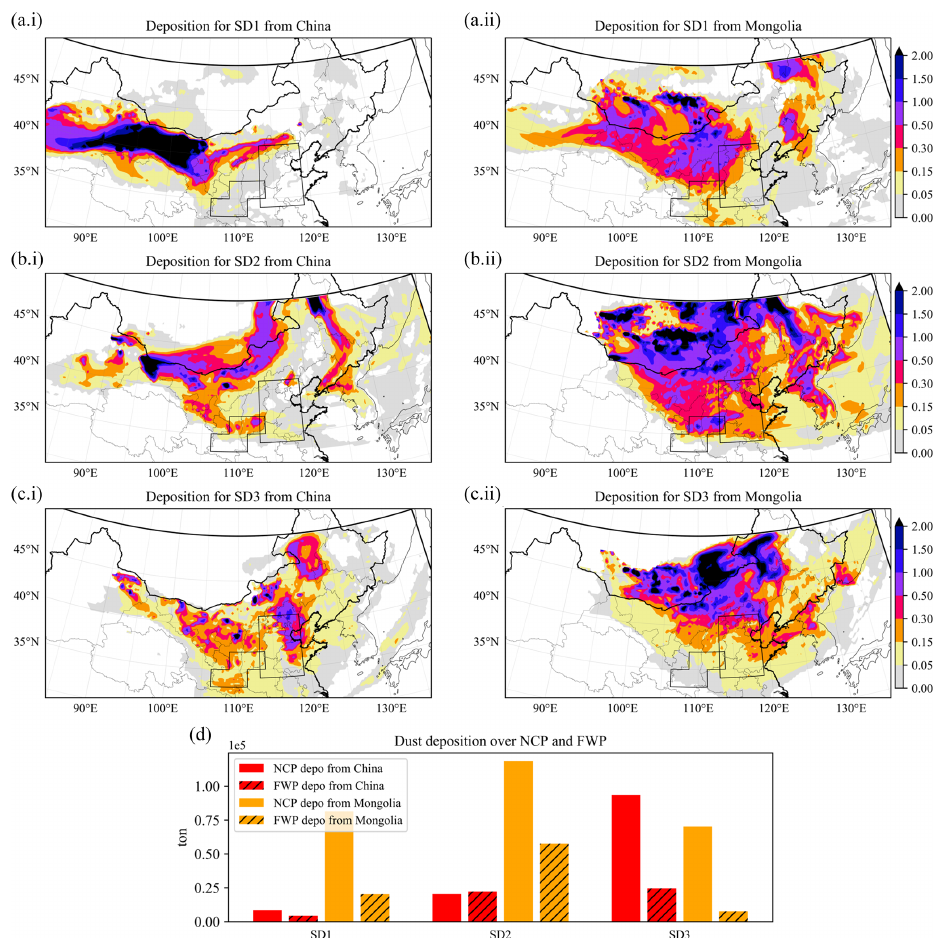
Figure 8. Spatial patterns of deposition of dust originating from China (i) and from Mongolia (ii) . Panel (d) shows the total mass of dust deposition on NCP and FWP either from China or from Mongolia during SD1 (a) , SD2 (a) , and SD3 (c)